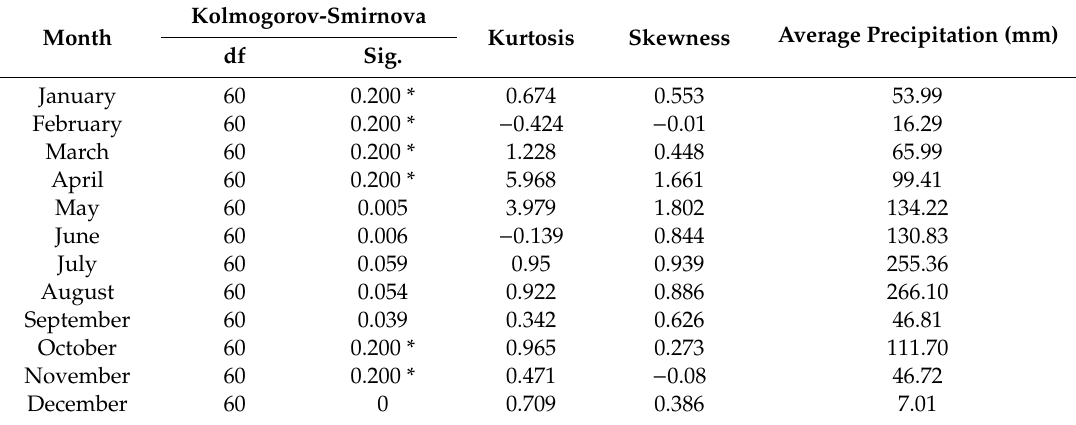
Figure 11. The average precipitation of Hubei. Table 4. The normality test of residuals between GTWR and the actual precipitation.